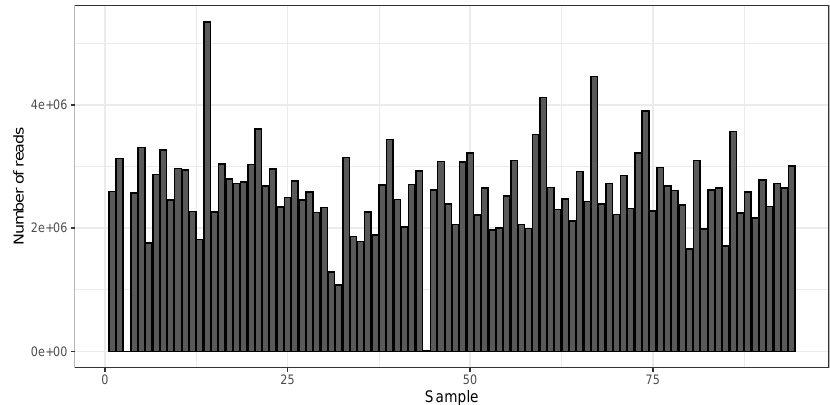
Figure 1. Number of reads. Number of reads generated for each sample.